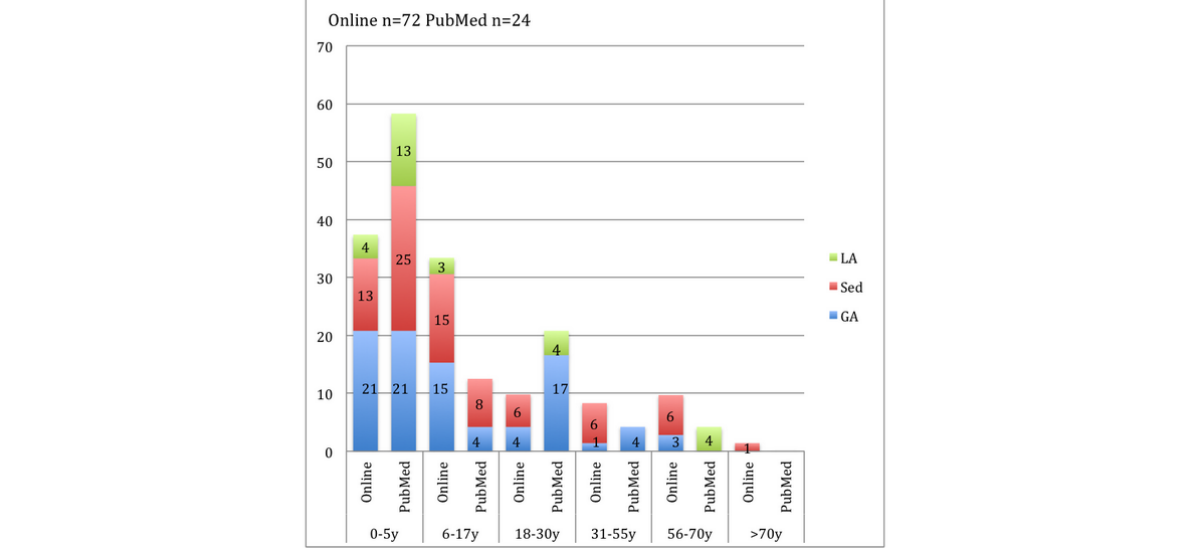
Figure 4. Percentage of deaths in dental facilities reported in online and PubMed publications categorized as anesthesia, medication, or sedation with the use of general anesthesia (GA), sedation (Sed), or local anesthesia (LA) in each age group (years, y). Possible duplicates were not